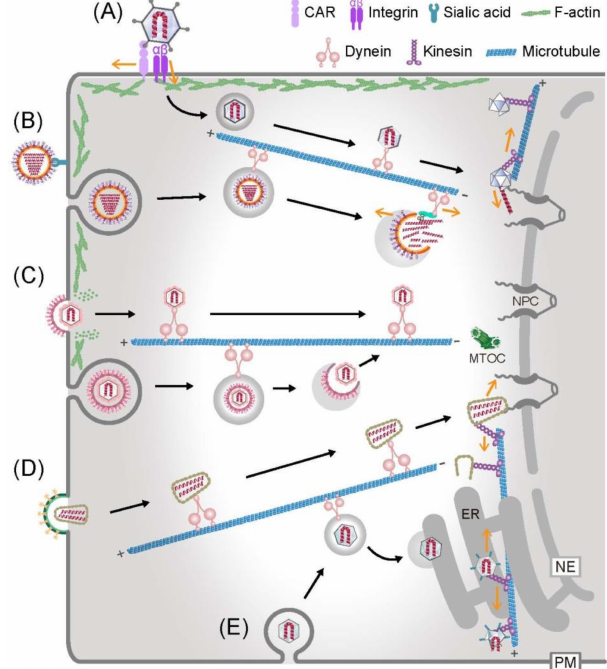
Figure 1. Examples of virus entry and interactions with the cytoskeleton with a focus on microtubules. Adenovirus (A), influenza virus (B), herpesvirus (C), human immunodeficiency virus (D) and simian virus 40 (E) enter into the cytoplasm either by a direct fusion of viral membrane and host plasma membrane (PM), or by receptor-mediated endocytosis, endosome rupture, or endoplasmic reticulum (ER) membrane penetration. Subsequently, viruses engage with the cytoskeleton and motor proteins to move towards the replication sites. Mechanical forces from the virus–motor protein interactions and opposing forces, such as actin-anchored integrins (A), the nuclear pore complex (NPC) (A), reverse transcription in the viral particle (D) or the site of ER penetration (E) are thought to facilitate virion disruption and release the viral genome (dark yellow